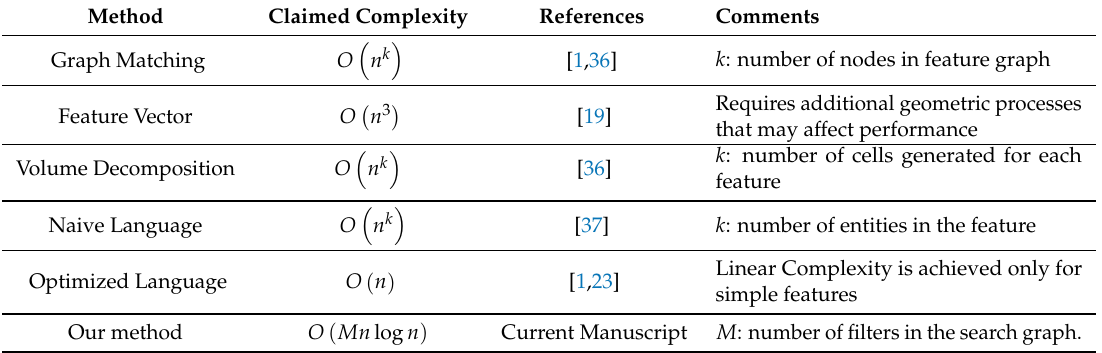
Table 1. Time complexity comparison between Feature Recognition (FR) approaches for a model with n entities.